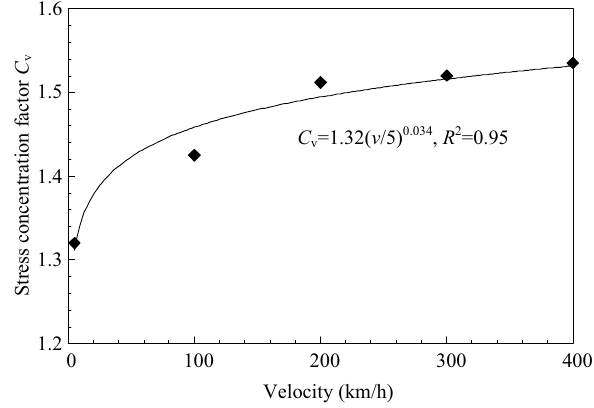
Fig. 11 Stress concentration factor C v on the roadbed versus the